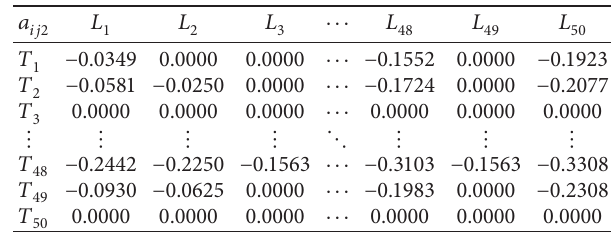
Table 7: Profit and loss matrix F housing rent.